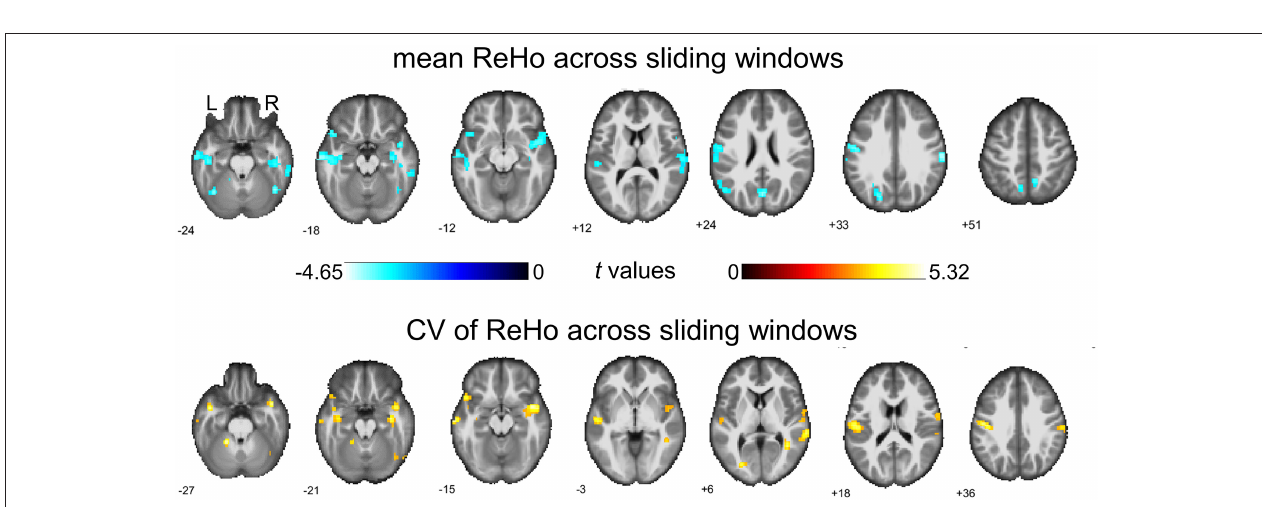
FIGURE 2 | Between-group differences of coefficient of variation (CV) of ReHo across different sliding window methods (the Hamming window, Hann window, and rectangular window) with various window sizes (window size = 10 TRs, 30 TRs, 50 TRs, and 70 TRs).